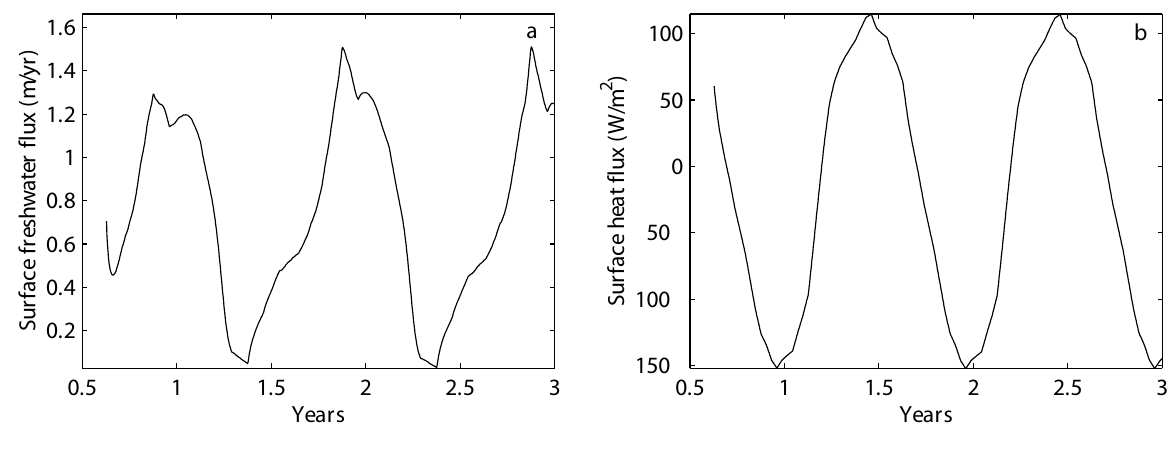
Fig. 9. Basin averaged time series of (a) kinetic energy (b) temperature and (c) salinity, corresponding to ALERMO’s climatological integration.